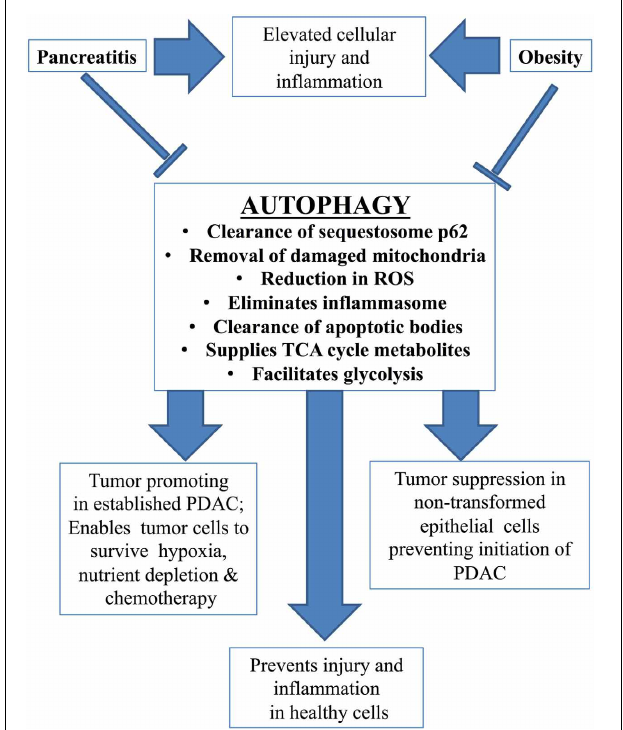
FIGURE 2 | Autophagy and pancreatic disease. Autophagy is responsible for clearance of aggregates of the sequestosome p62, damaged mitochondria, apoptotic bodies, the inflammasome, and reduces levels of reactive oxygen species (ROS). This limits injury and inflammation in healthy cells and prevents neoplastic transformation and initiation of PDAC. Therefore the role of autophagy is normally beneficial. In tumor cells, however, autophagy promotes survival, enabling cancer to resist hypoxia, nutrient depletion, and chemotherapy. Pancreatitis and obesity lead to arrested autophagy resulting in elevated cellular injury and inflammation. This can predispose to chronic disease and even progression to